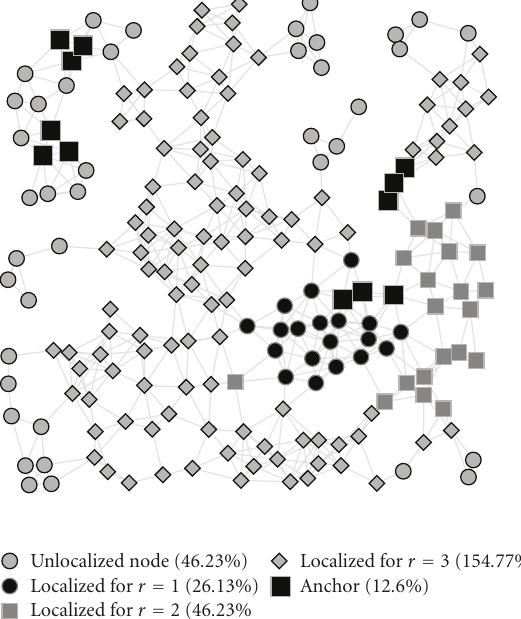
Figure 3: Random network with n = 200 and k = 6. Squares are localized for r = 0 (anchors), purple circles for r = 1, dashes for r = 2, diamonds for r = 3, and gray circles are unlocalizable.